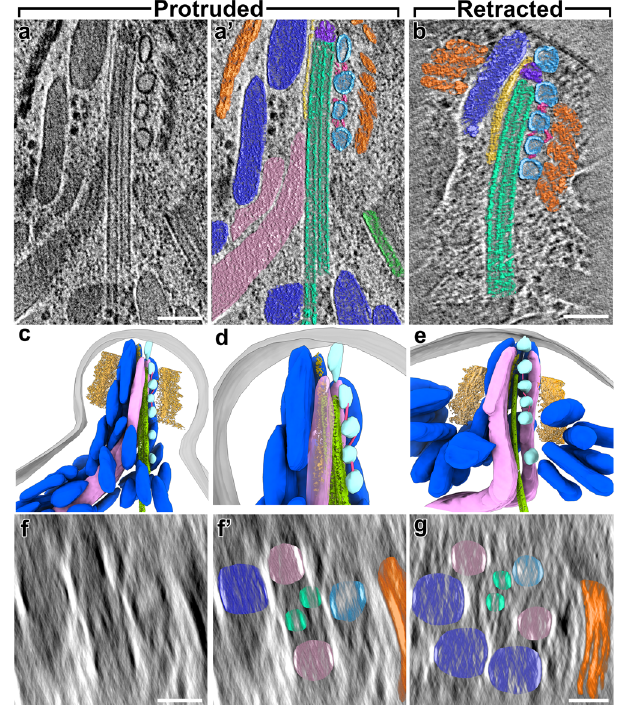
Fig. 6 | The apical secretory machinery is organized around the intraconoidal microtubules(ICMT)inboth protrudedandretracted states.a , b Tomographic slices show the apical tip of a N. caninum cell with the secretory organelles orga- nized around the ICMT (green) inside the protruded conoid complex in long- itudinal views ( a , a ’— protruded original and pseudo-colored; b — retracted). The long ICMTs connect the apex of the conoid to the cytosol, and are closely co- localizedwiththesecretoryvesicles(lightblue)andtworhoptries(rose).Notethat themembrane-associated,most-apicalvesicleisnotvisibleinthetomographicslice shownin( a ),butisvisibleinpanels( c , d )andFig.7b.Othercoloring:CFs(orange), micronemes (dark blue), sheet-like density (gold), inter-vesicular connections (pink), “ crowning ” density that caps the apical minus-end of the ICMT (purple). c – e 3D segmentation and visualization of tomograms shown in ( a and b , respectively), i.e., with protruded ( c , d ) and retracted ( e ) conoid, showing the overall organization of secretory organelles within the conoid complex, including CFs (trimmed from the front to show the content inside), micronemes, rhoptries, ICMT,vesicles,inter-vesicularconnections,sheet-likestructurealongmicronemes, and plasma membrane (gray). d shows a zoom-in from ( c ), with conoid fi bers hidden for clarity. f , g Cross-sectional slices through the protruded ( f , f ’— original and pseudo-colored) and retracted ( g ) conoids from the tomograms shown in ( a and b ). Scale bars: 100nm (in a , b ); 50nm (in f , g